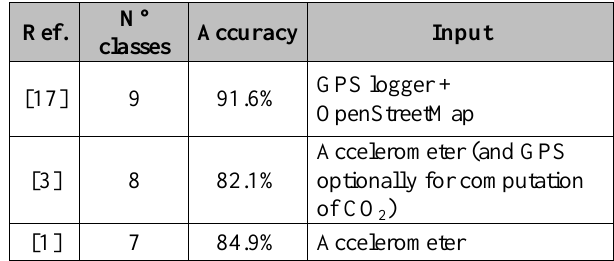
Table 3. PROs and CONs of server-based and smartphone-based solutions in the implementation of the classification